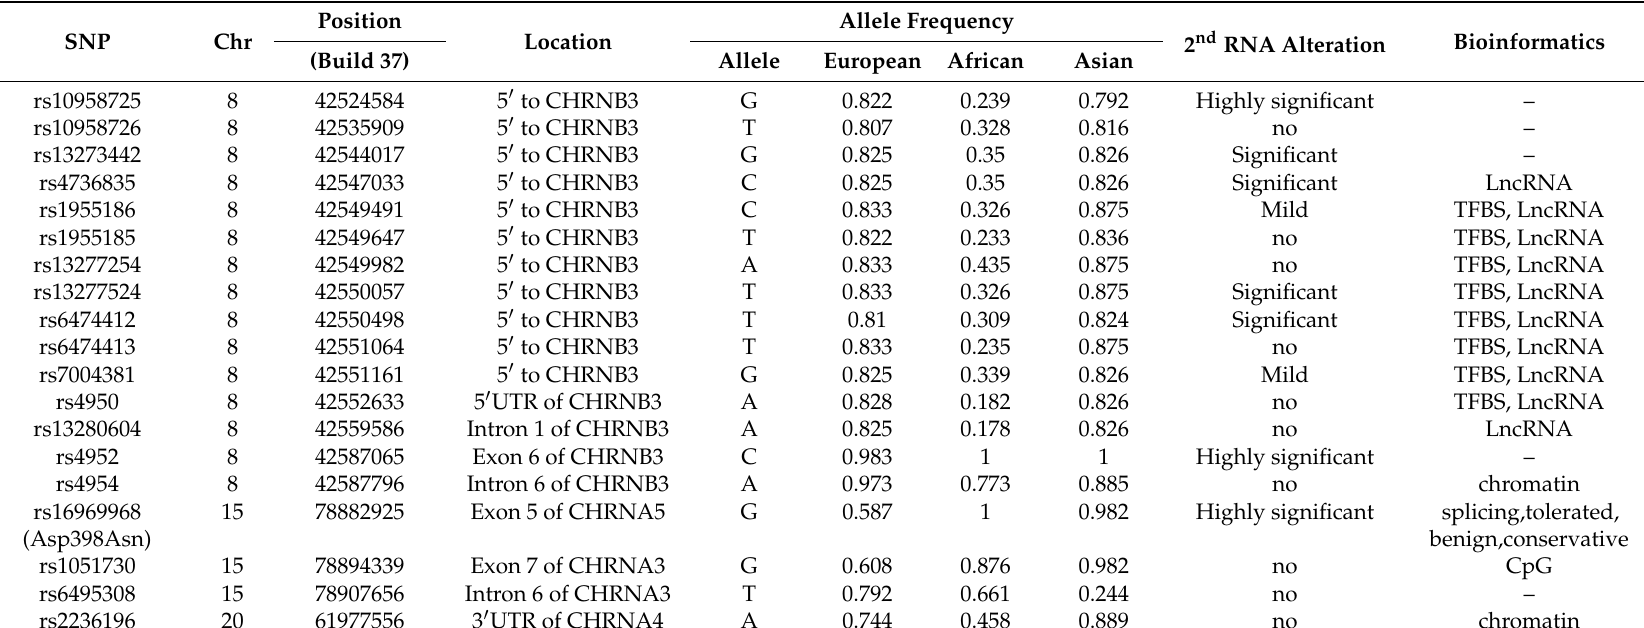
Table 5. Bioinformatics analyses on replicable risk CHRN